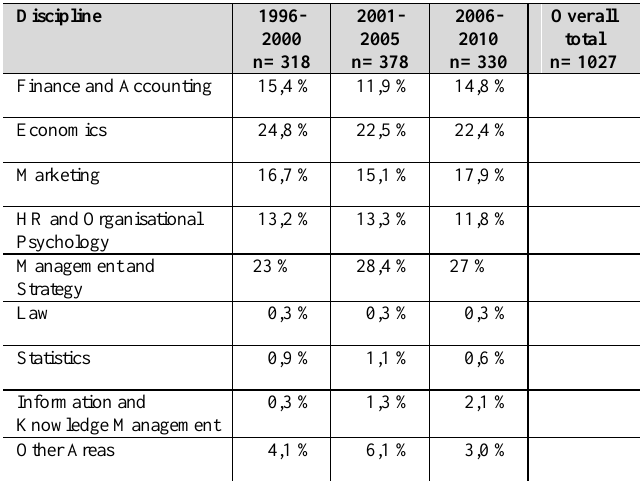
Table 5 summarizes the distribution of published disciplines Table 5: Discipline of all management articles over